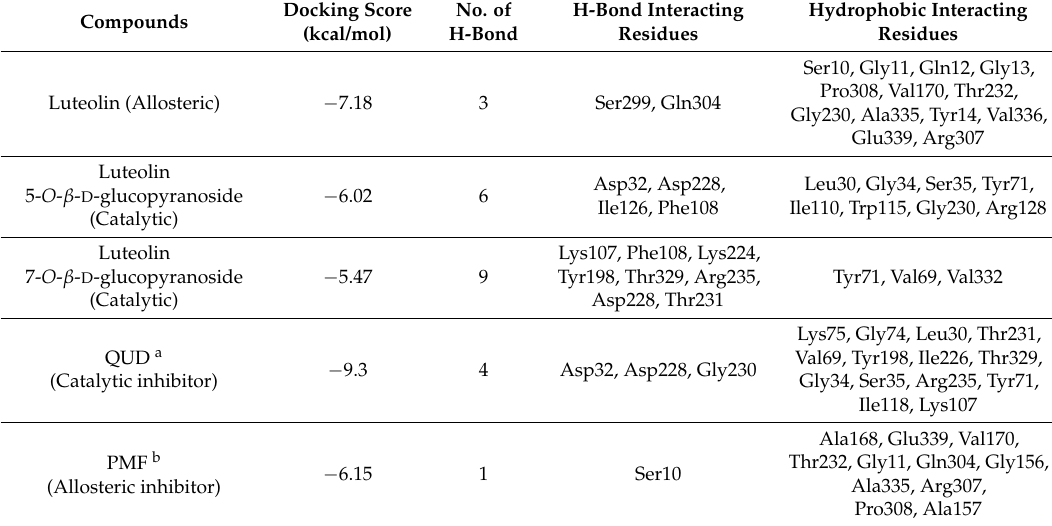
Molecular interactions of the BACE1 (2WJO) active site with luteolin, luteolin 5- O - β - D -glucopyranoside and luteolin 7- O - β - D -glucopyranoside as well as reported inhibitors.